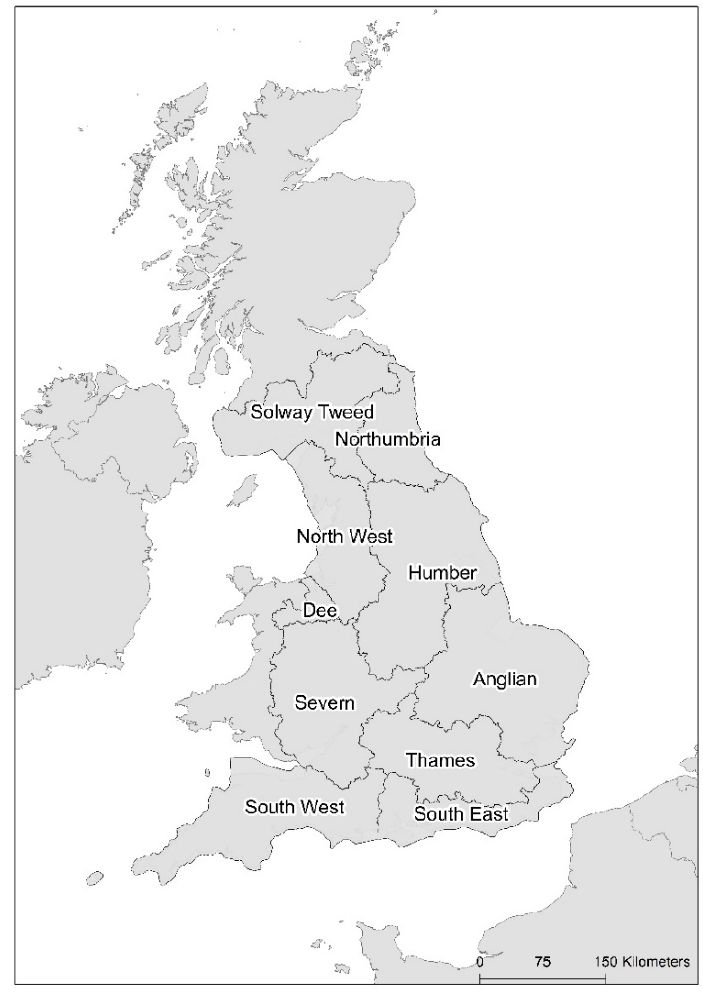
Figure 5. Map showing the regions used for testing regional metals action levels [9]. Figure adapted from